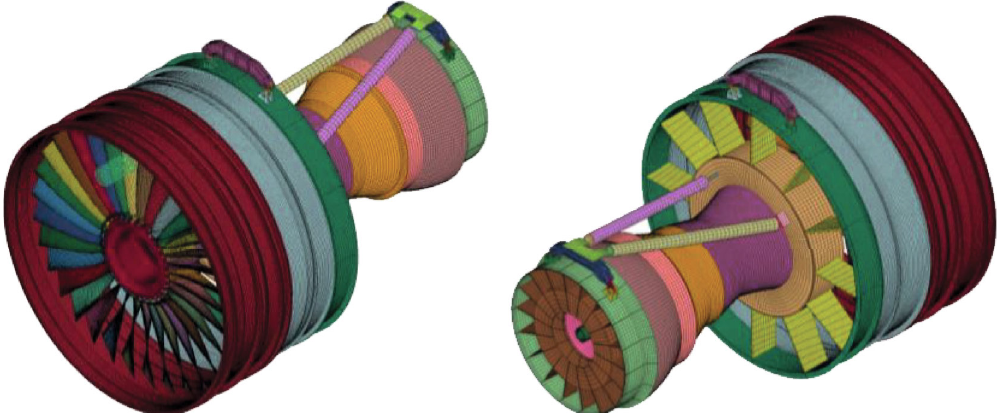
Figure 4: Finite model of whole